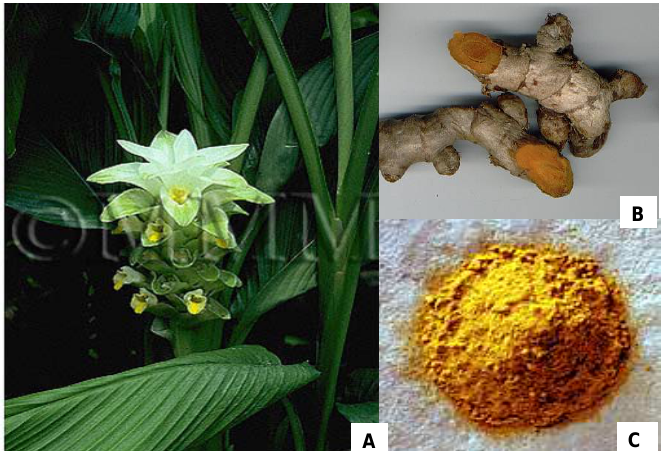
Figure 1. Pictures of the botanical sources of